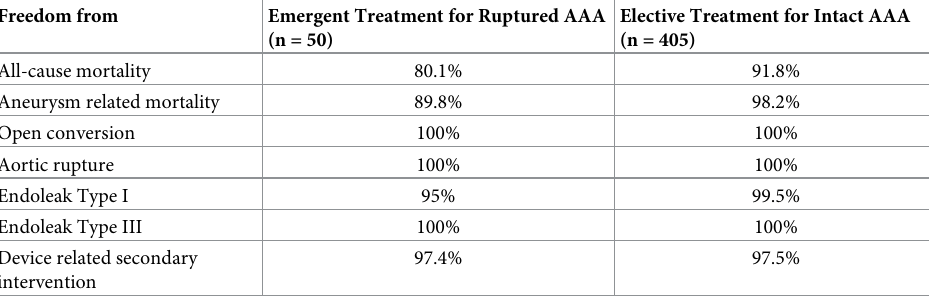
Table 1. Freedom from aneurysm related outcomes.